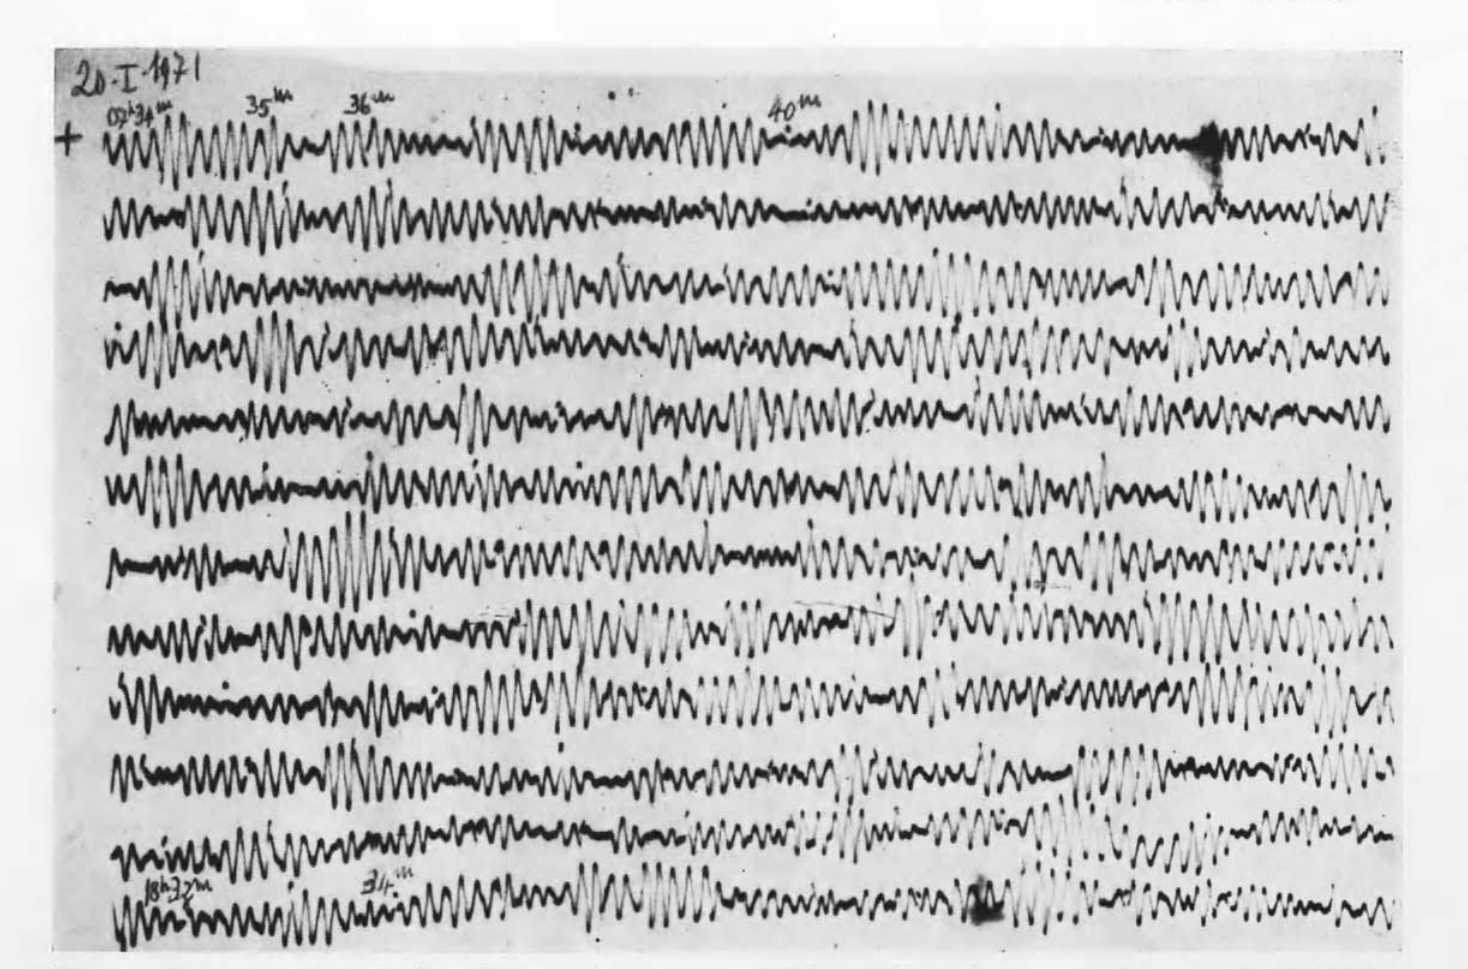
Fig. 38 - Vertical long lJeriod "l'ress-Ewing" l'omponent. of Toledo (Cf.~r.T.). The long period seismographs installed in Tole<lo rocord Oli ./an. 20, and 21 1971 ahnost exdusively and with higll amp[it.ttrles the mieroseisllls of abouì. 8 seeond periods (S"-8',5) derivillg from the large Atlantic. cyclonic. lJerturbation indicat.ed in figures 34 and 35. Wldle in Rome t.he passage of the Tyrrhenian perturbat.ion brings forth microseisllls of about 4 soc (fig. 37) which cover those frolli the At[antic. originating at almost 2000 kms from Rome, since the forllier are near the origin·area, no tra<'.e of mil'roseisIlls of Tyrrllenian origin was m8<"l.sured in Tolet!o which is about t.he same dist.ance from the t.wo perturbation l'entres. Tllis is chiefly due t.o the energy of the air-water interaetion of the Atlantic cycLonic. perturbat.ion wllich is far lligher than that of t.he TYlTllenian Sea, as well as to t.lle fad, at least. partially, t.hat the former act.s at. a fttndamental period rat.e wllic.ll is about. twice t.he rate lJeculiar t.o tlle